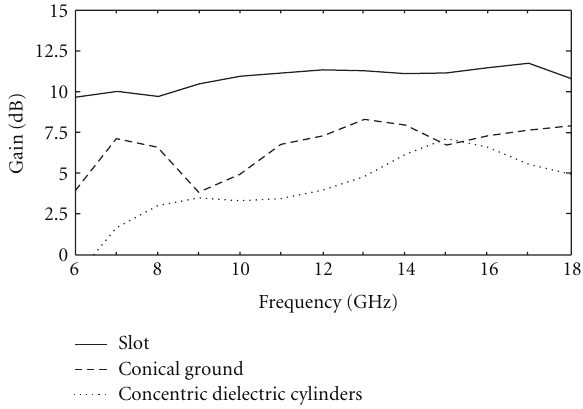
Figure 11: Maximum gain as a function of frequency for the slot- sinuous with 200 μ m substrate compared with the maximum gains attained by the strip sinuous with conical ground, and the strip sinuous with concentric cylinders of varying permittivities in the backing